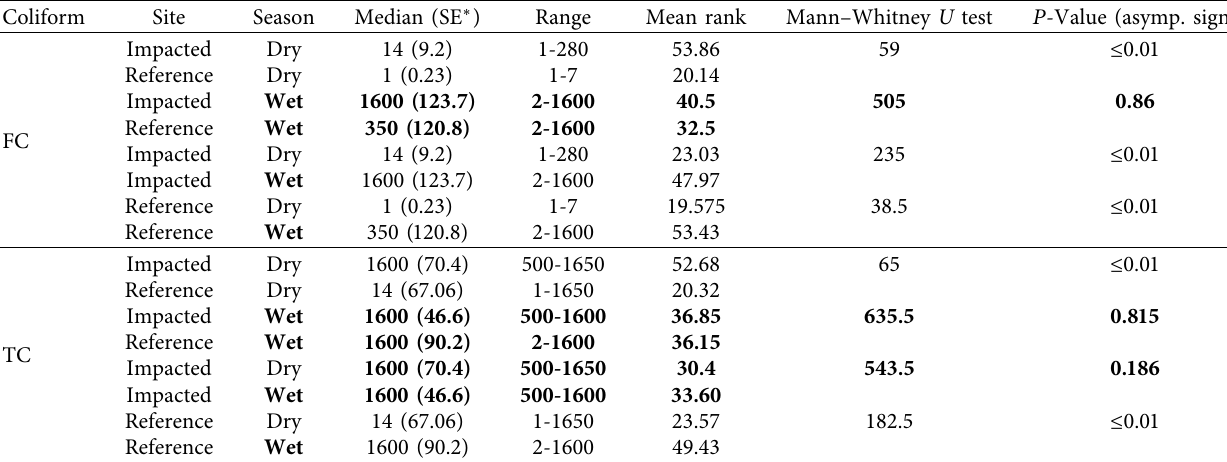
Table 2: Median count (standard error) of coliform counts in water samples collected from Southern Gulf of Lake Tana ( n � 36), 2021. Coliform